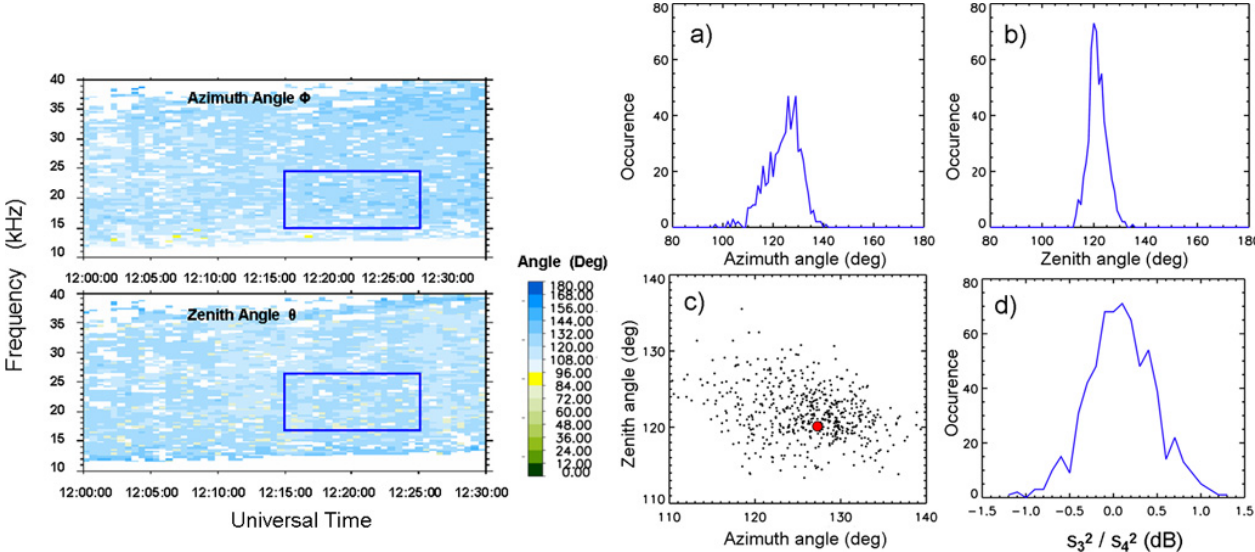
Fig. 7. DSM tool applied to a frequency–time domain during 18 May 2008 event. Elementary runs treat the signal at a fixed frequency bin (320Hz width) measured on C3 and C4 during an interval of 60s. Left: frequency–time spectrograms of derived ray path vector orientation angles (azimuth and zenith) in GSE coordinate system. Right: distribution of quantities derived from the runs inside the pointed frequency– time domain (blue rectangle); (a) azimuth angle occurrence, (b) zenith angle occurrence, (c) zenith versus azimuth, and (d) ratio of electric field powers measured on C3 and C4 along the common antenna orientation.